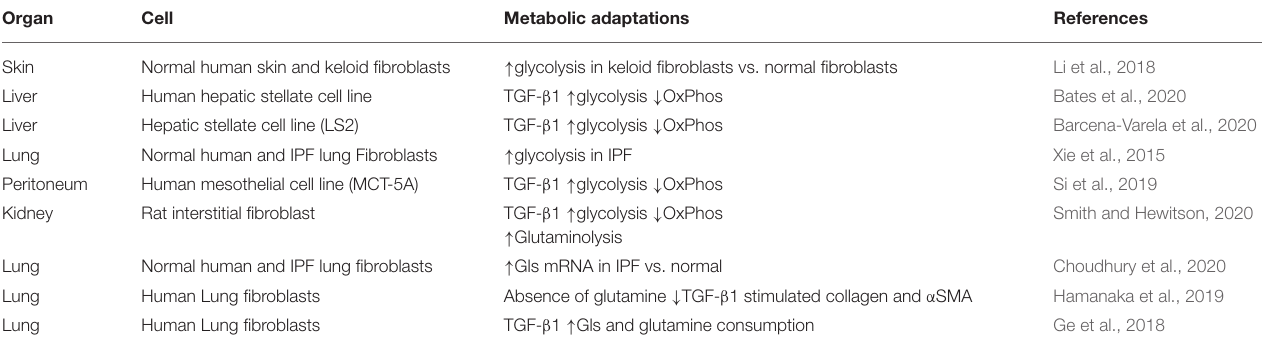
TABLE 1 | Representative in vitro examples of metabolic adaptations in fibroblast-like cells. Organ Cell Metabolic